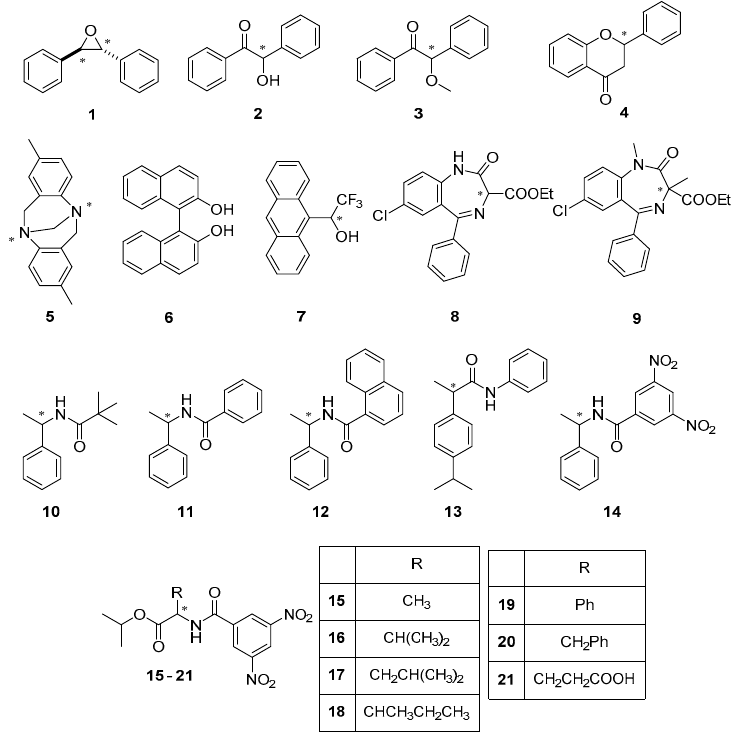
Figure 2. Structures of the racemic analytes used for the evaluation of prepared CSPs.